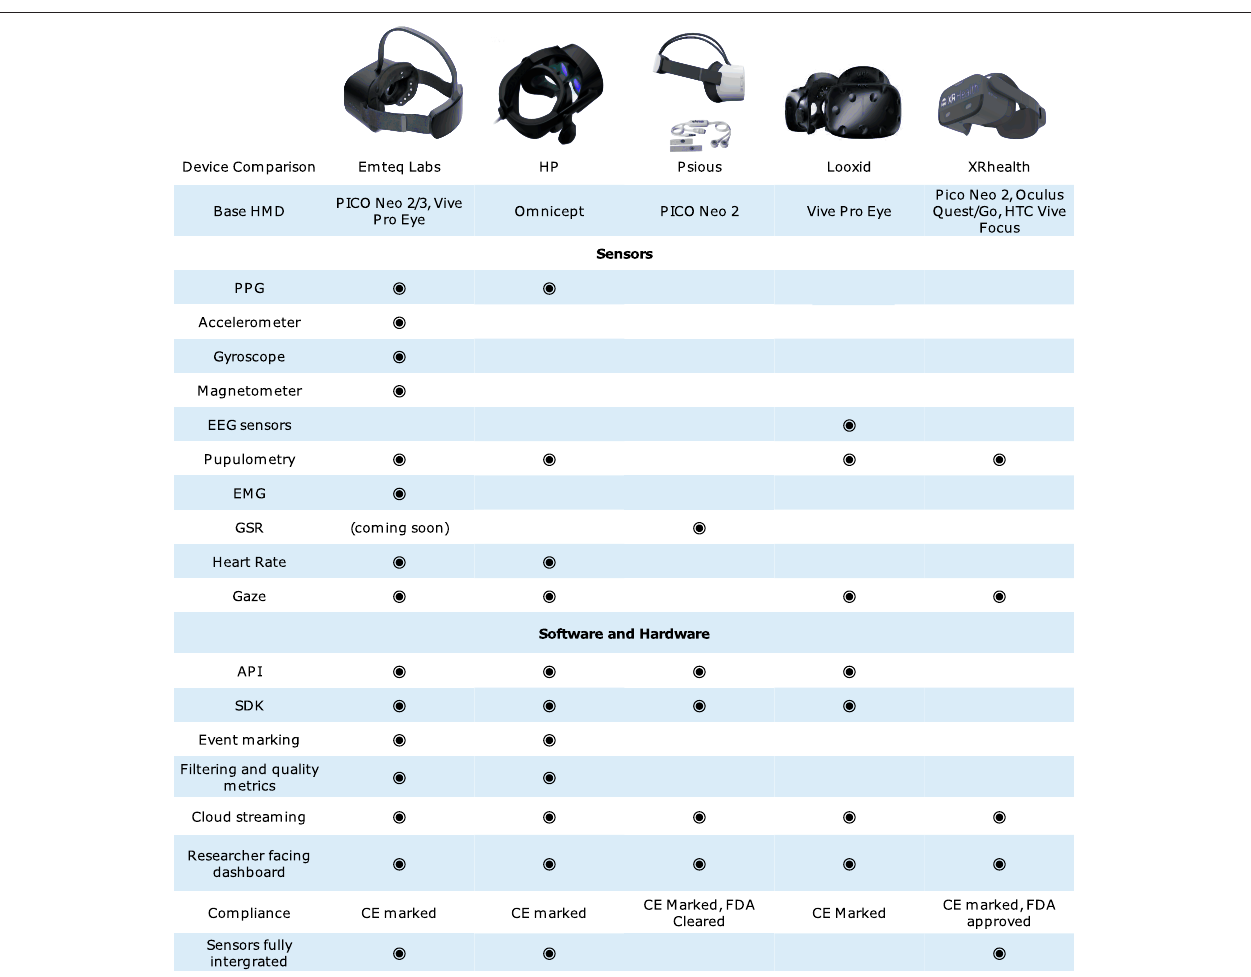
Frontiers in Virtual Reality |